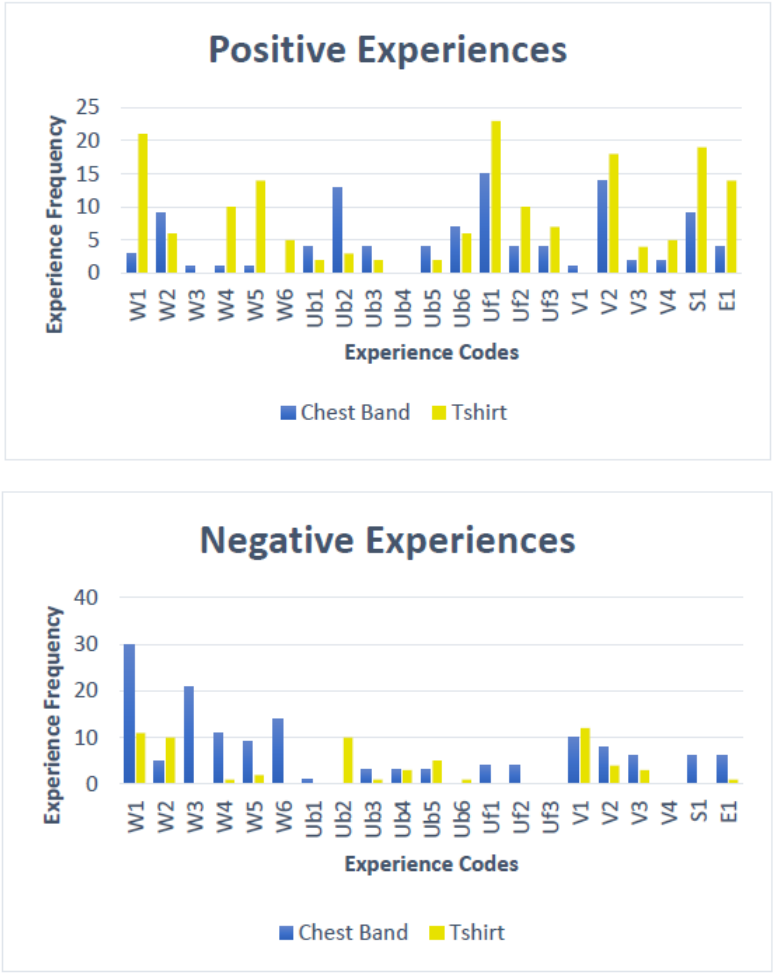
Figure 5. Comparison of positive and negative experiences between the accessory-based wearable chest band and textile-based wearable T-Shirt.